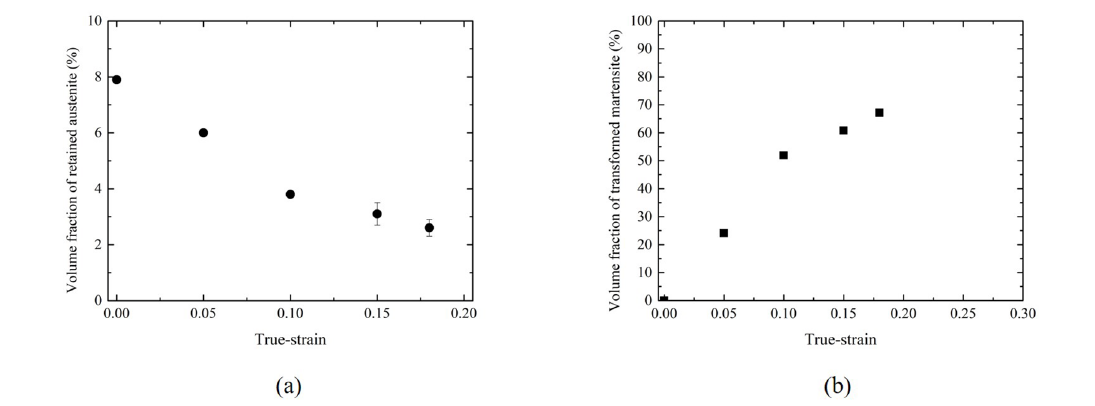
Figure 6. The volume fractions of (a) retained austenite and (b) strain-induced martensite determined from the as-received condition and increasing pre-strain levels in uniaxial tensile loading.